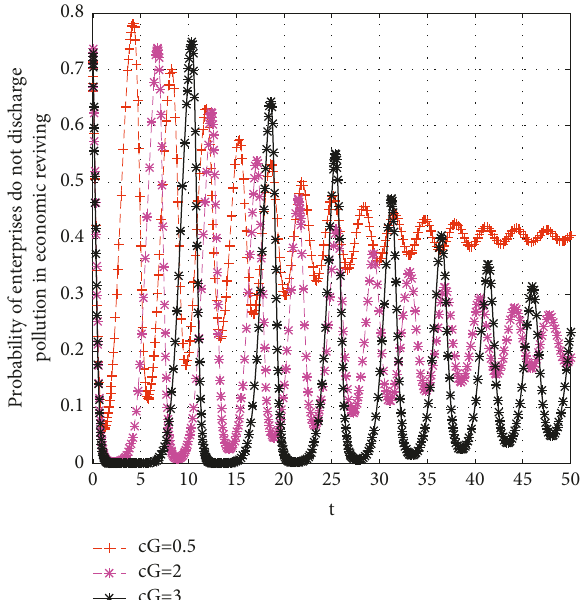
Figure 13: The evolution path of nondischarge of enterprises when government costs increase under the dynamic incentives mecha- nism and penalties